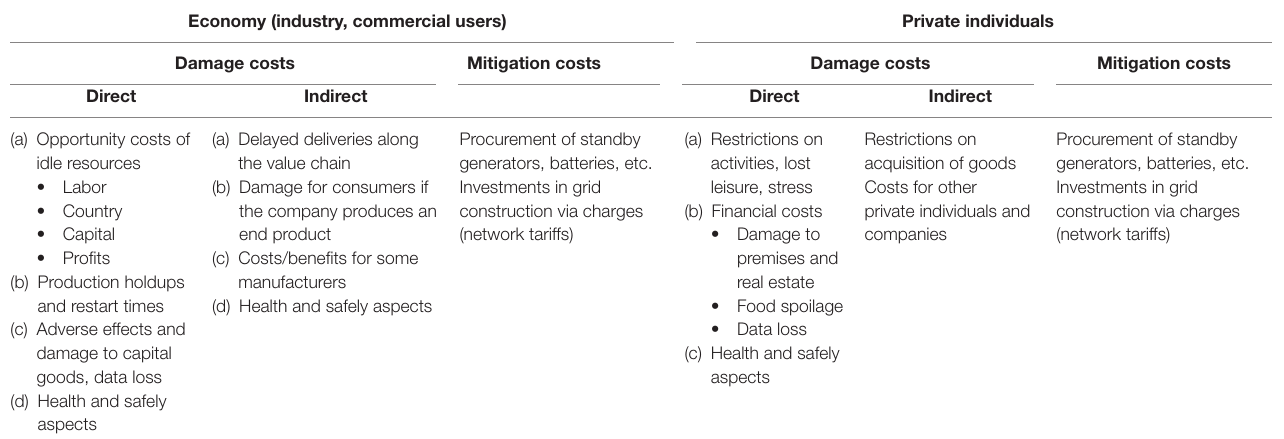
TABLe 2 | Structure of damage and mitigation